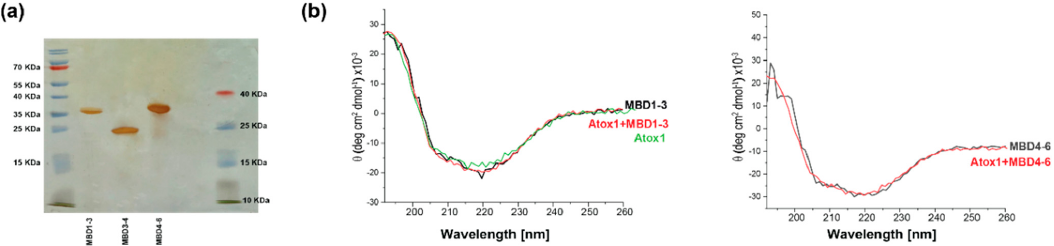
Figure 2. ( a ) SDS-gel picture of MBD1-3 (34.9 KDa), MBD3-4 (21.6 KDa) and MBD4-6 (29.2 KDa). ( b